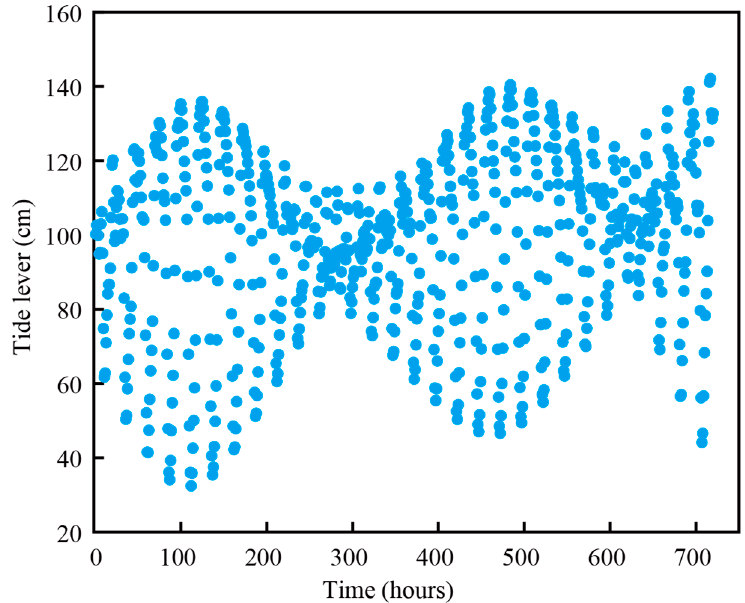
Figure 10. The variation of tide level in April in study area.